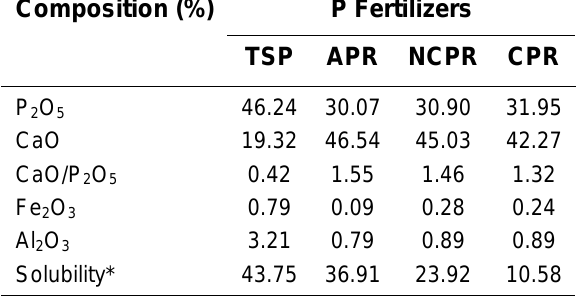
Chemical Properties of the P Fertilizers